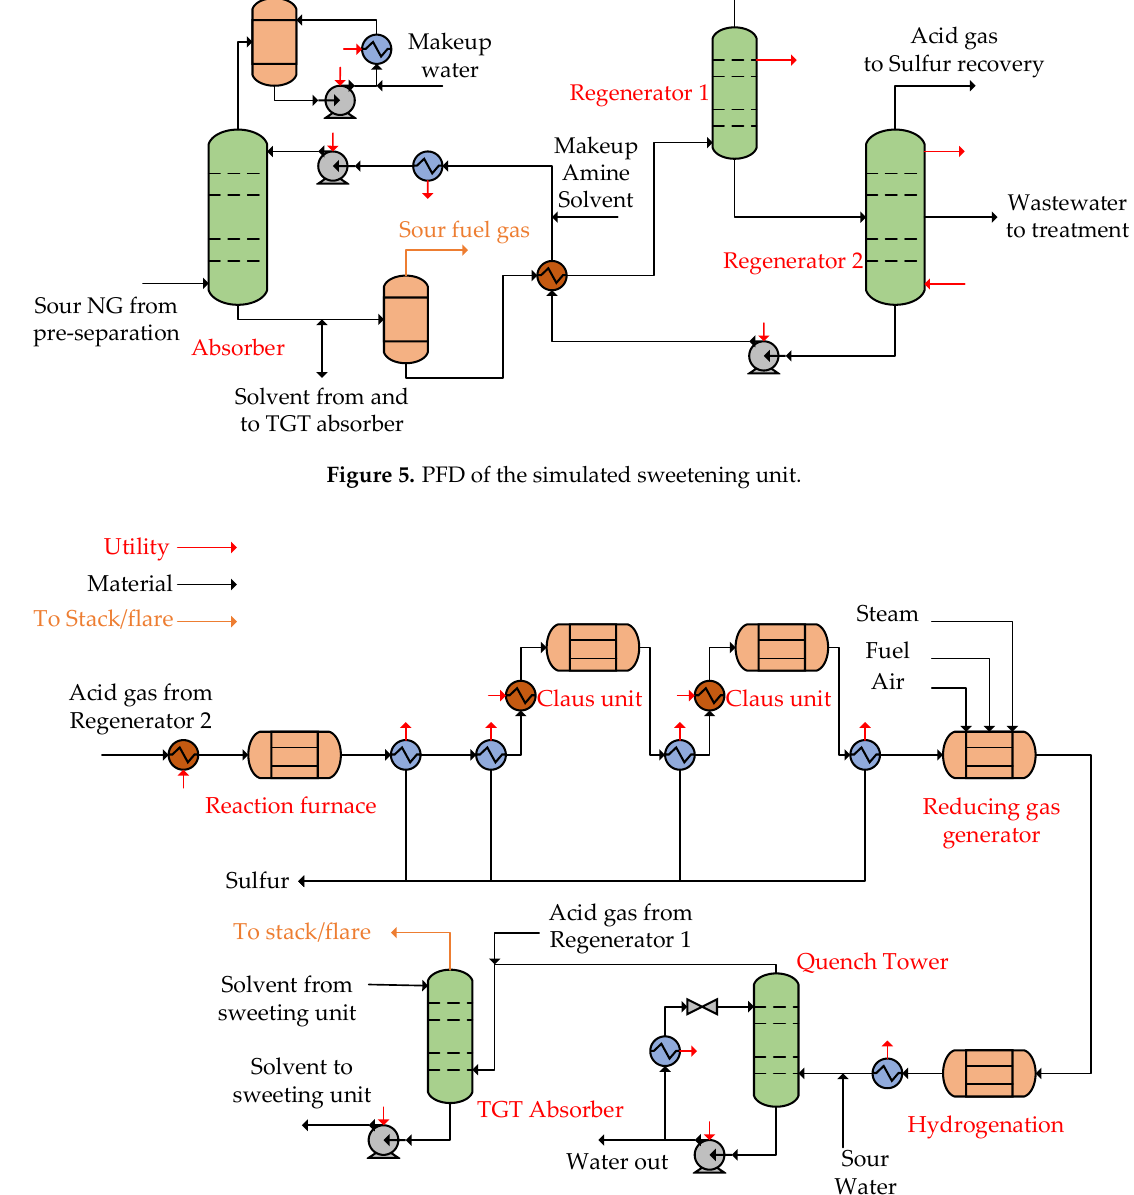
Figure 6. PFD of the simulated SRU/TGT unit.